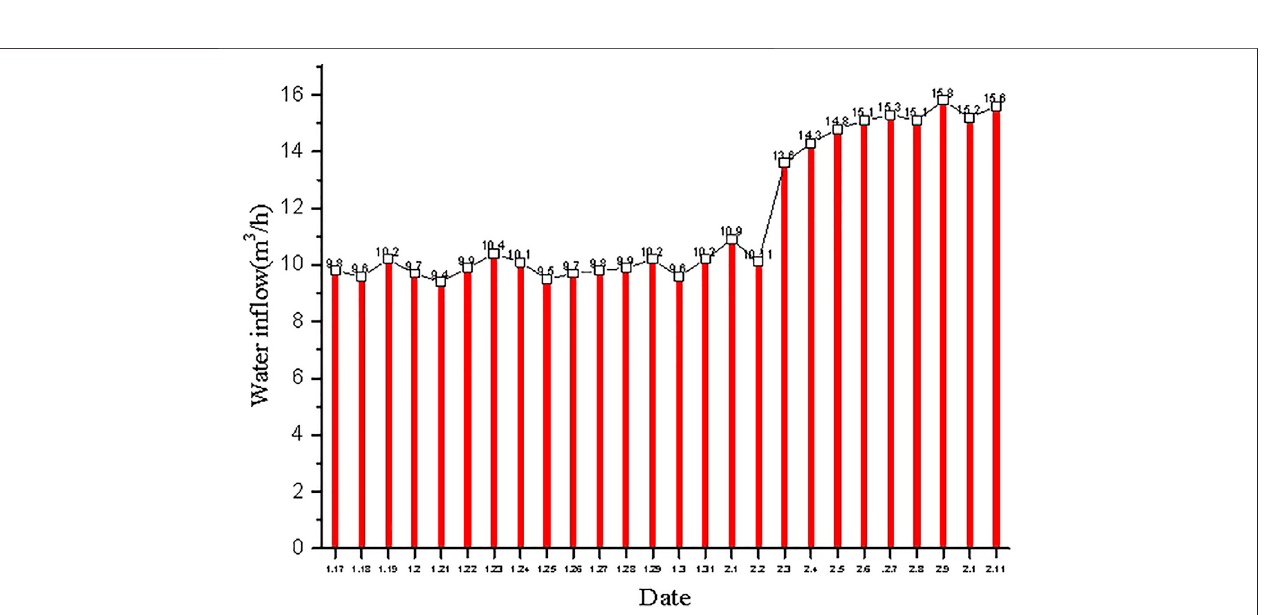
FIGURE 3 | Location of gully and observation lines.